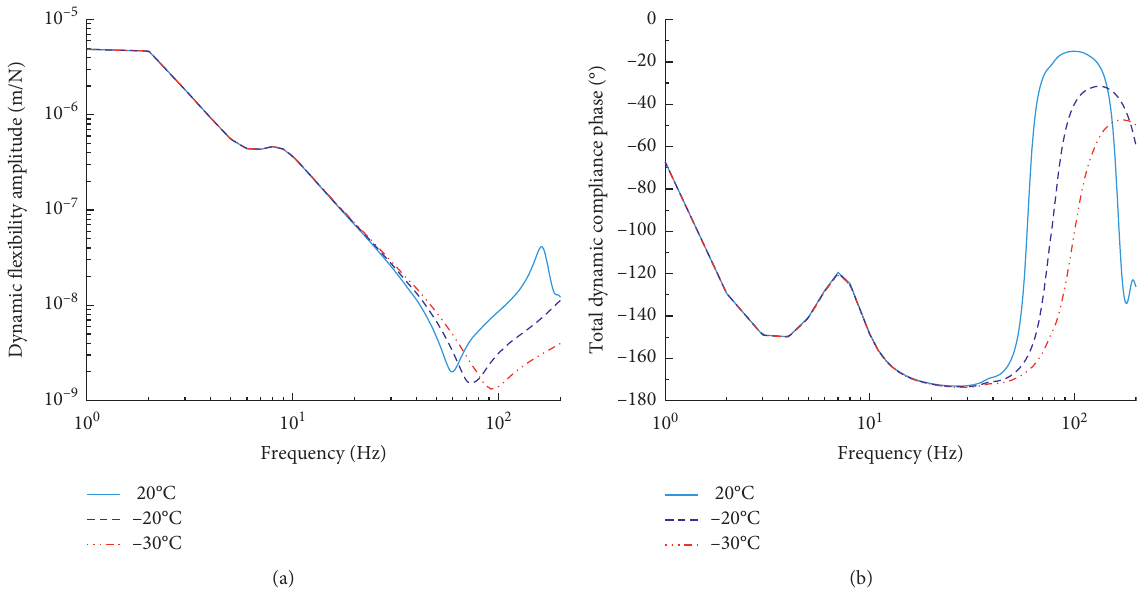
Figure 14: Amplitude and phase of total dynamic flexibility of rubber cushion car-rail-bridge system under different temperatures: (a) amplitude; (b) phase.